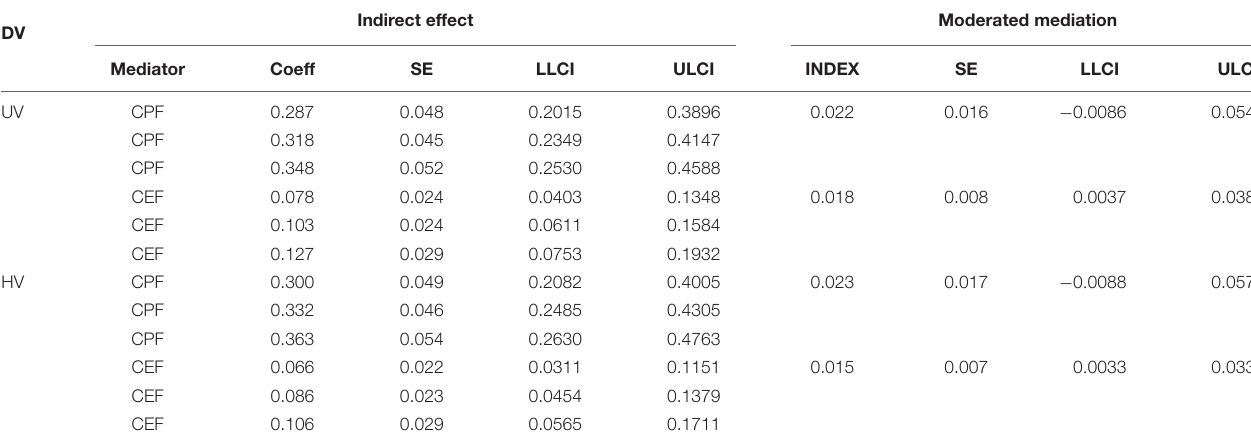
TABLE 7 | Analysis of the moderated mediation (other-efficacy).